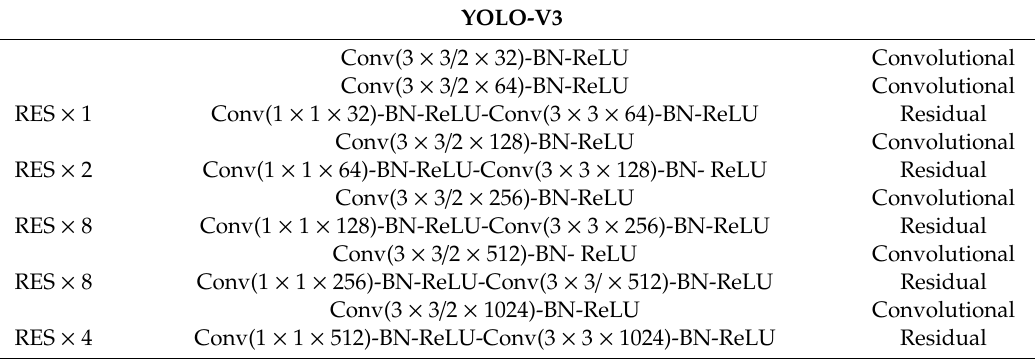
Table 1. The parameter settings of the feature extraction network of